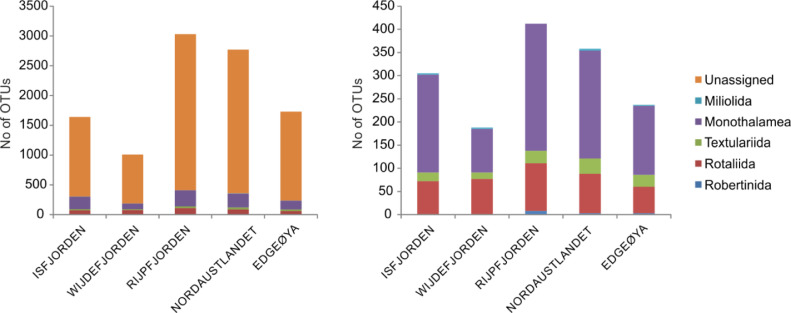
Number of OTUs found in each sampling locality, including unassigned OTUs (left panel) and excluding unassigned OTUs (right panel).